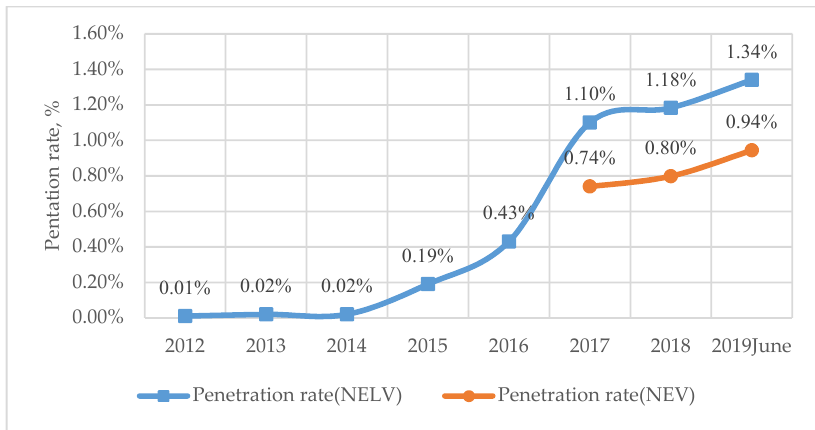
Figure 2. Industrial progress of new energy logistics vehicles (NELVs).